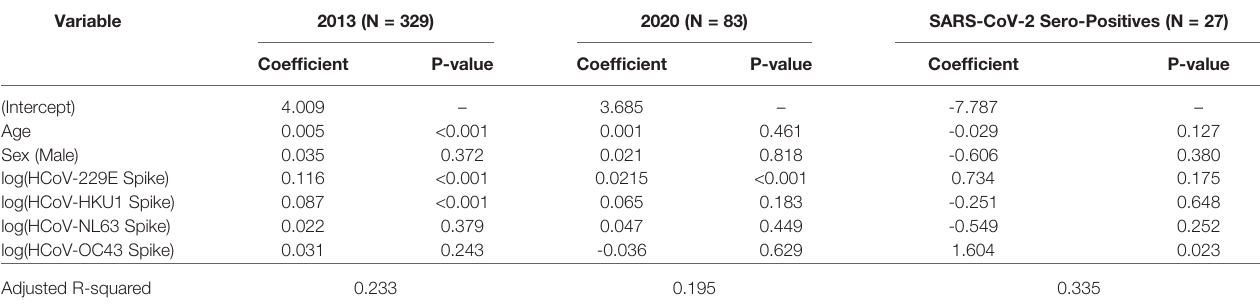
TABLE 3 | Multiple linear regression analysis of anti-SARS-CoV-2 RBD IgG antibody levels above positivity cutoff in SARS-CoV-2 sero-negative individuals (2013 and 2020) and SARS-CoV-2 sero-positive individuals, with adjustment for age, sex, and anti-HCoV IgG signals.